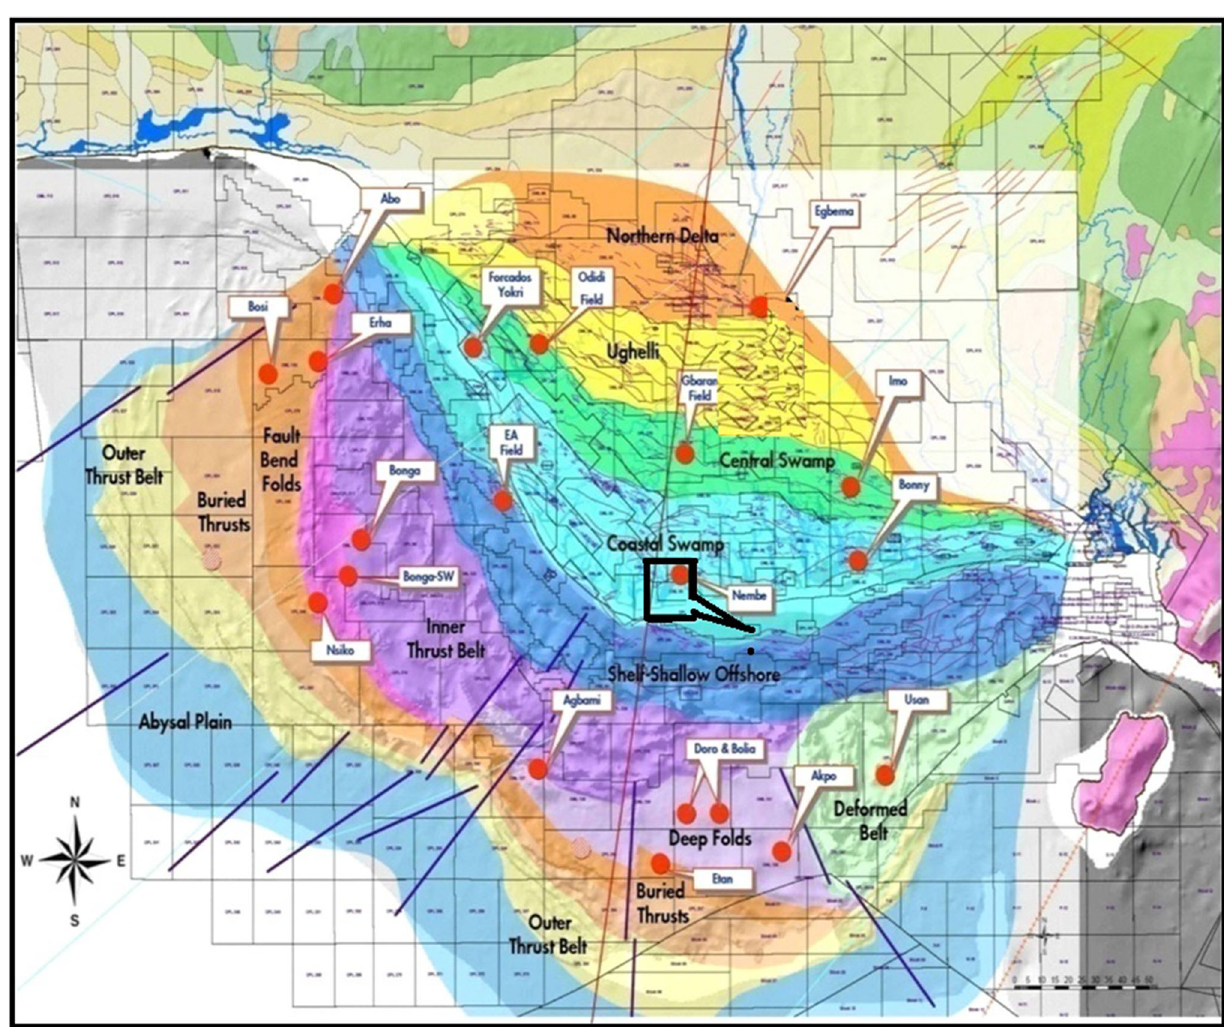
Fig. 1 Location map of Niger Delta showing the study